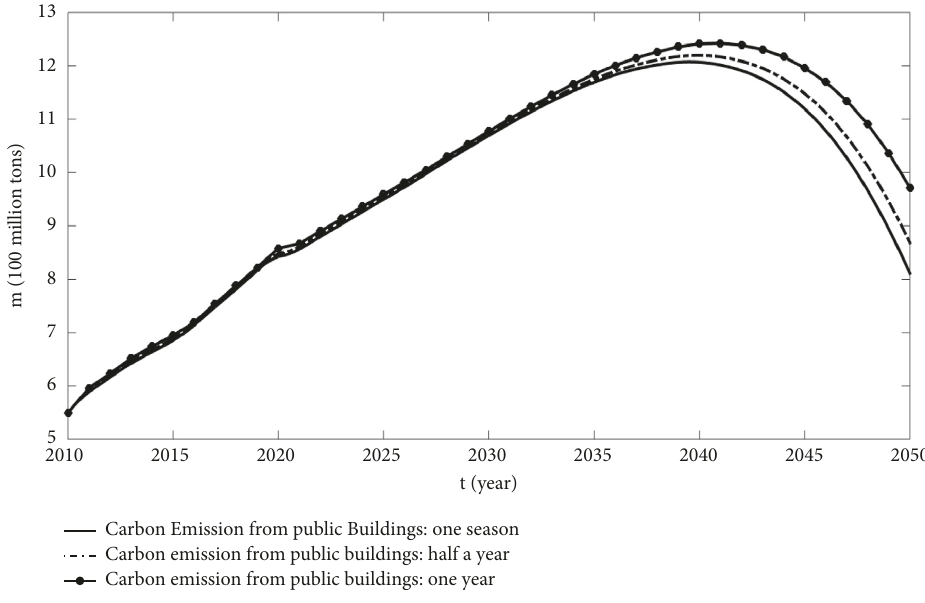
Figure 3: Inspection chart of the operating results of carbon emission system in public buildings. Table 3: The results of the historical test of the carbon emission system model for public buildings.